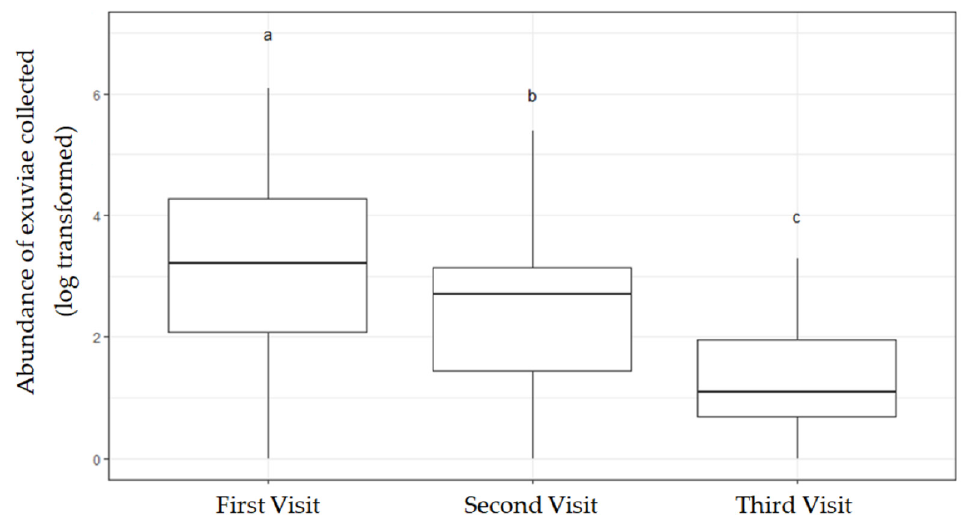
Figure 5. Abundance of exuviae collected (all species pooled) per 100 m long transects ( n = 98 transects) depending on the visit rank. Abundances are log-transformed. Box plots indicate median, range, and first and third quartiles. Significant differences are indicated by different letters.